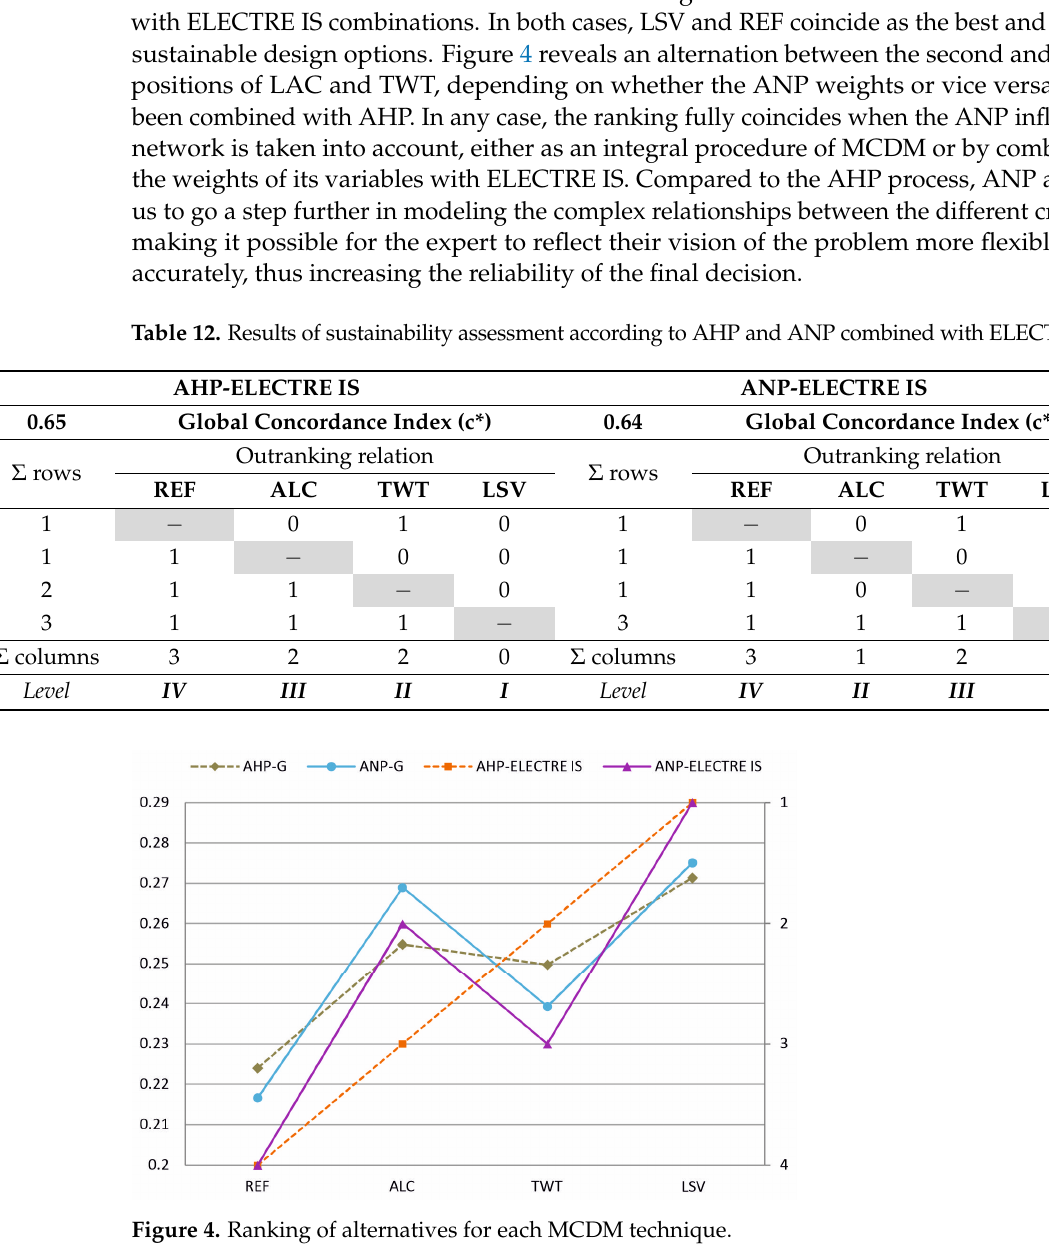
Table 11. Normalized decision matrix on impact assessment results and pseudo-criteria common to AHP and ANP-ELECTRE IS.